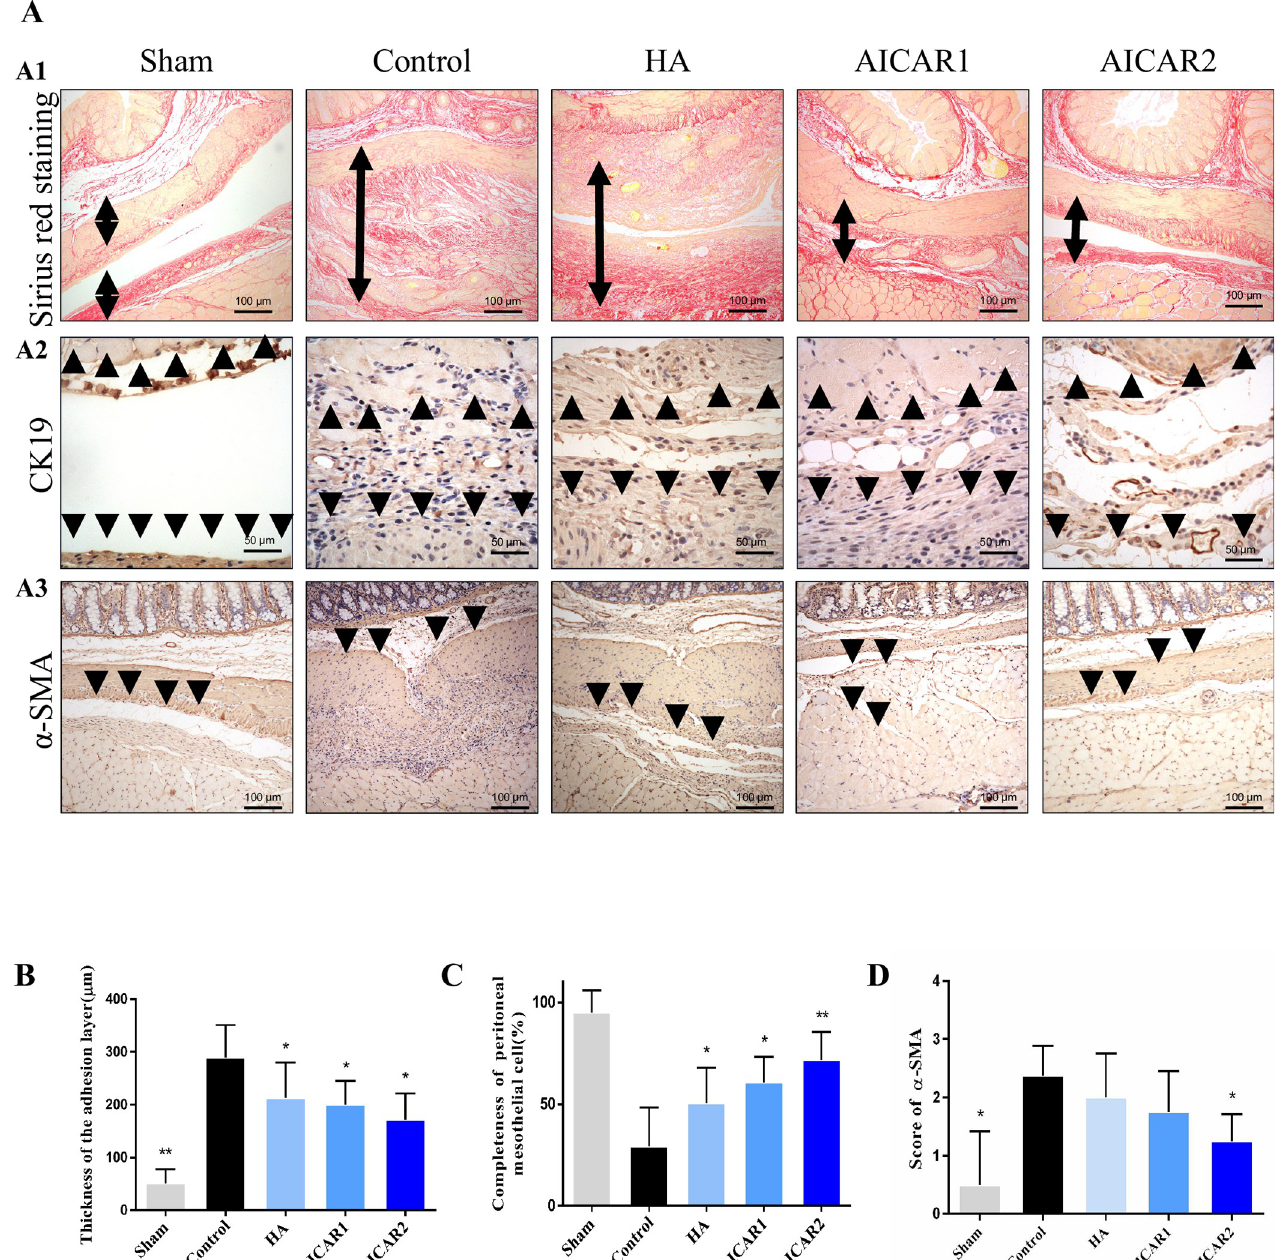
Fig 4. AICAR treatment inhibits tissue fibrosis and promotes peritoneal mesothelial cell repair in vivo . (A1) A typical picture of Sirius Red picric acid staining from each group. (A2) shows CK19 IHC staining from each group. The black arrow indicates the adhesion tissue or normal peritoneal tissues. (A3) α - SMA IHC staining from each group. The black arrow indicates the α -SMA staining. (B) The fiber thickness in each group was measured by Sirius Red picric acid staining, assessed by Kruskal–Wallis test. (C) The integrity of peritoneal mesothelial cells in each group, assessed Kruskal–Wallis test. (D) The tissue fibrogenesis in each group, assessed Kruskal–Wallis test. (compared to control, � represents p < 0.05, �� represents p < 0.01).